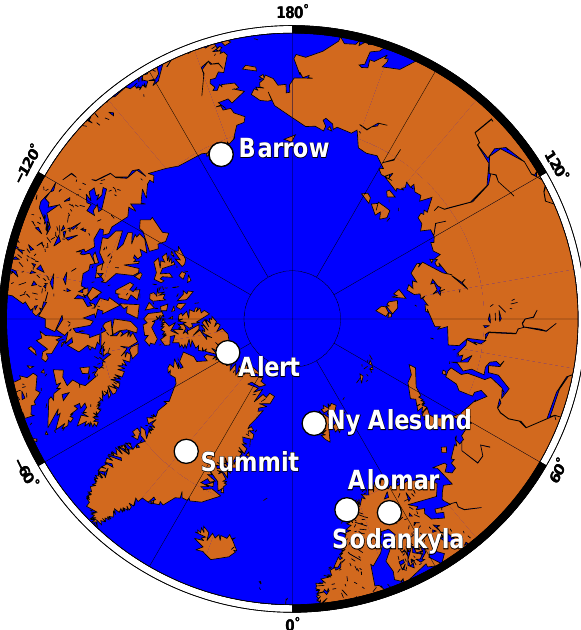
Fig. 1. Location of the six measurements stations considered in this